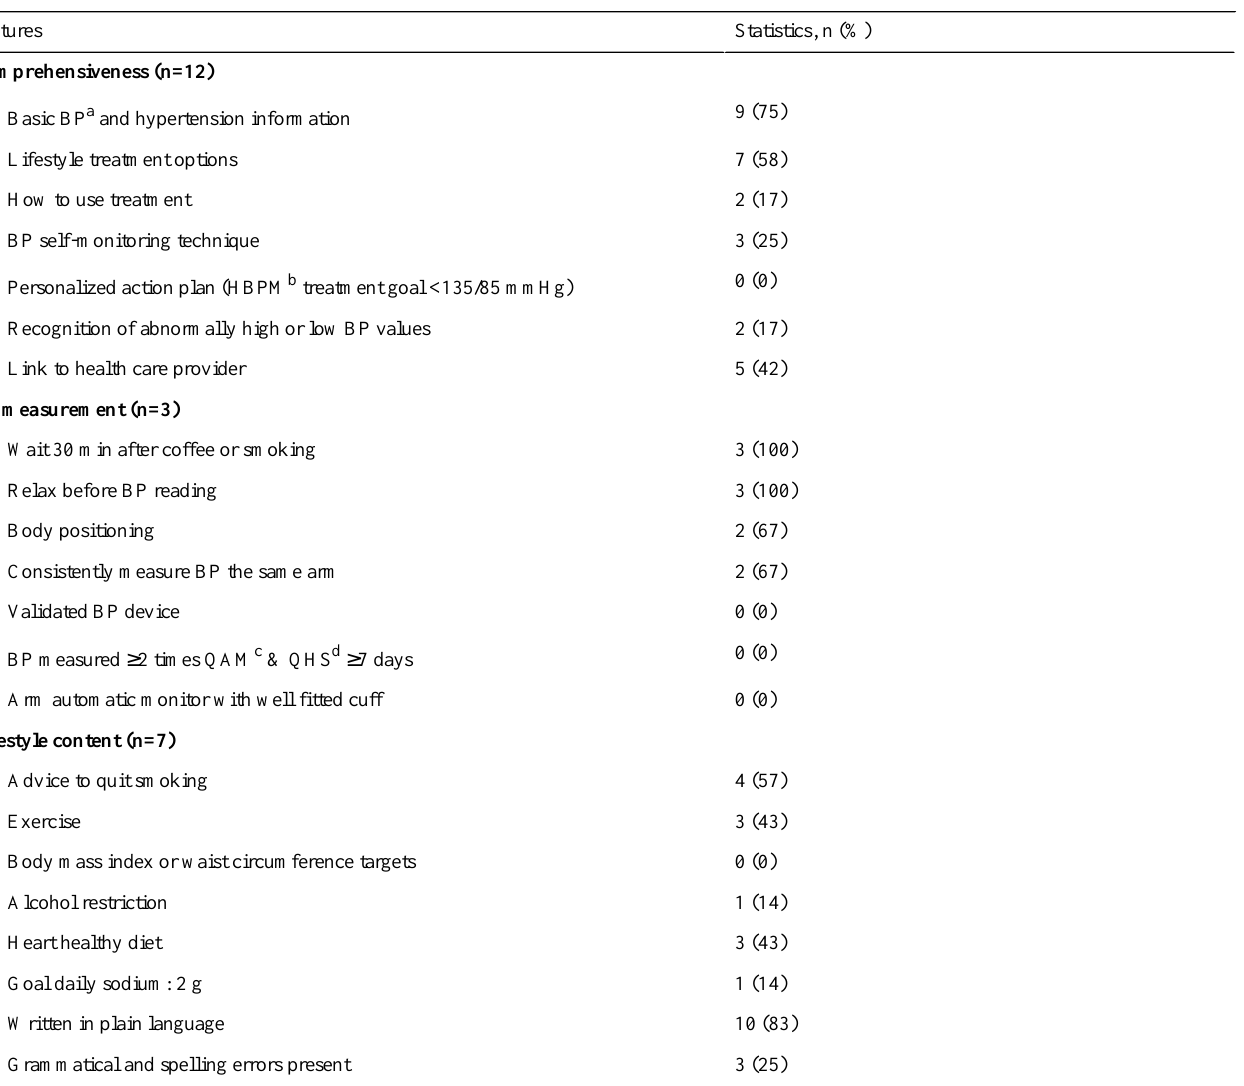
Table 3. Assessment of apps containing educational content.